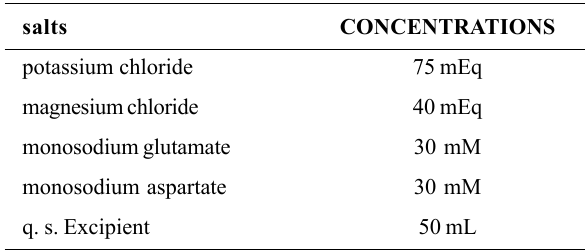
Table 2. Stock solution for induction of low-volume cardioplegia.